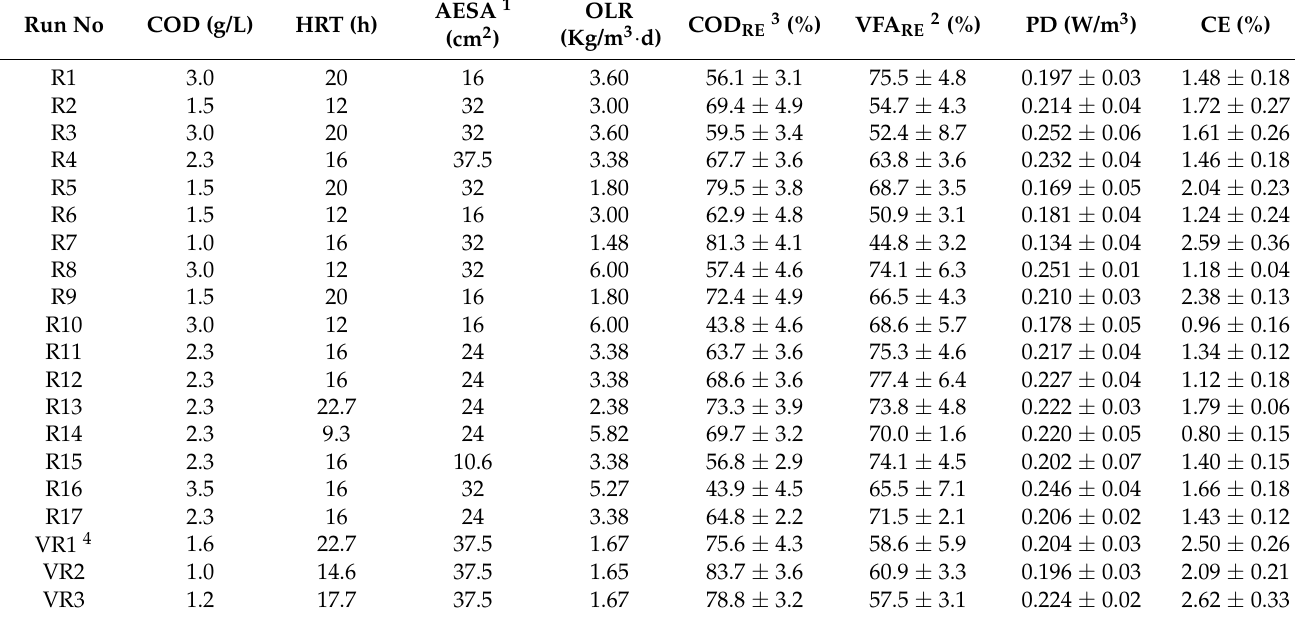
Table 1. An optimization run for